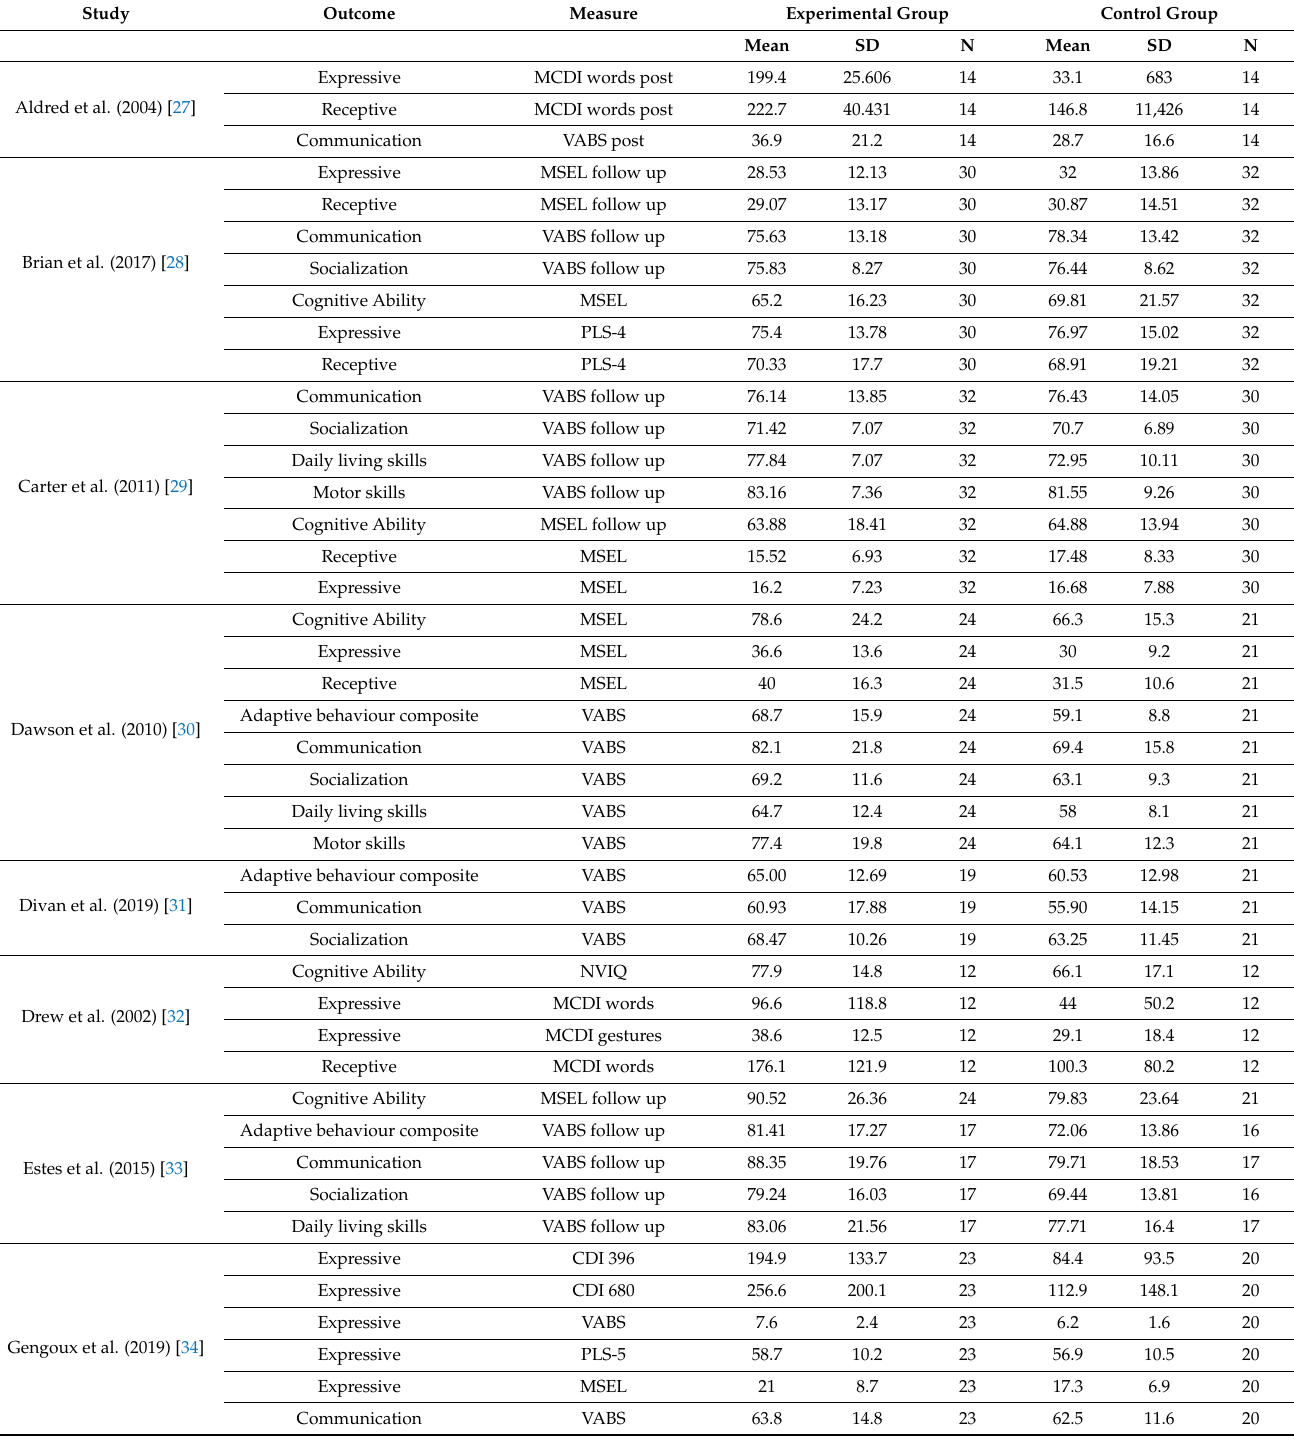
Table A1. Follow up data used in the